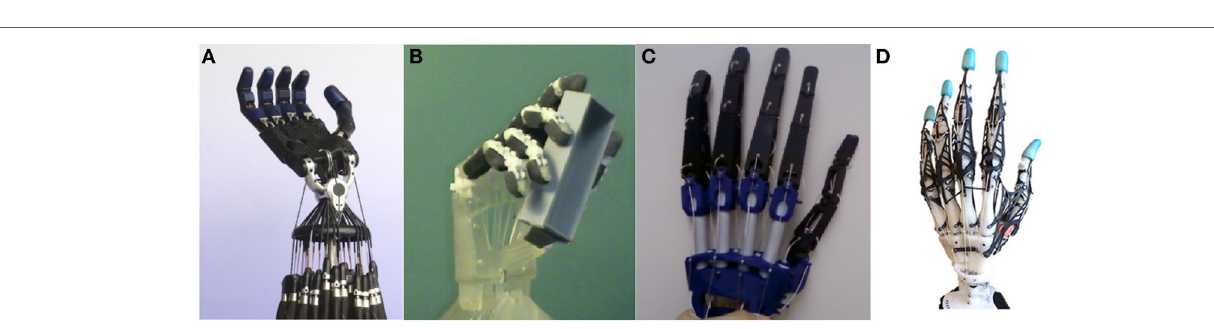
FigUre 2 | (From left to right) (a) Shadow hand (Rothling et al., 2007), (B) UB hand IV (Melchiorri et al., 2013), (c) Xu Zhe’s anthropomorphic robotic hand (Xu et al., 2013), and (D) Xu Zhe’s highly biomimetic robotic (Xu and Todorov,